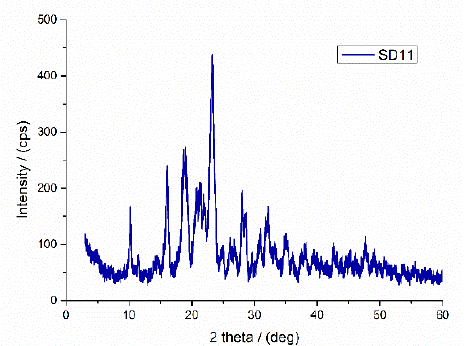
Figure 7. X-ray diffraction patterns of solid dispersions. Figure 7. X ‐ ray diffraction patterns of solid dispersions.